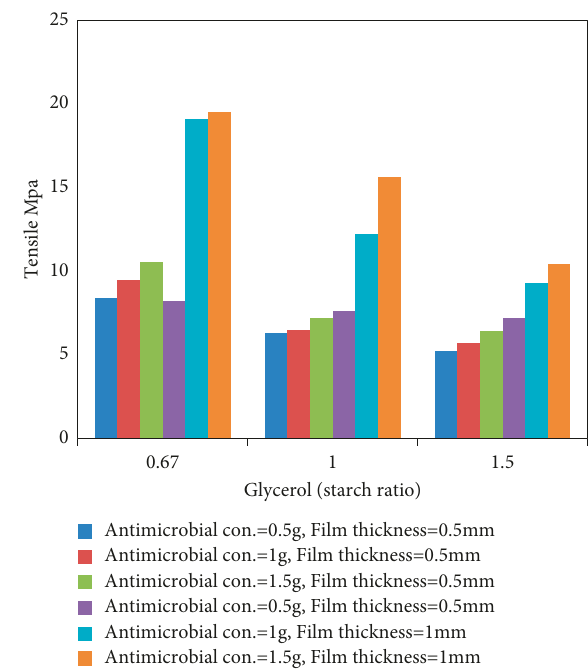
Figure 7: Tensile strength antimicrobial packaging film at different glycerol/starch